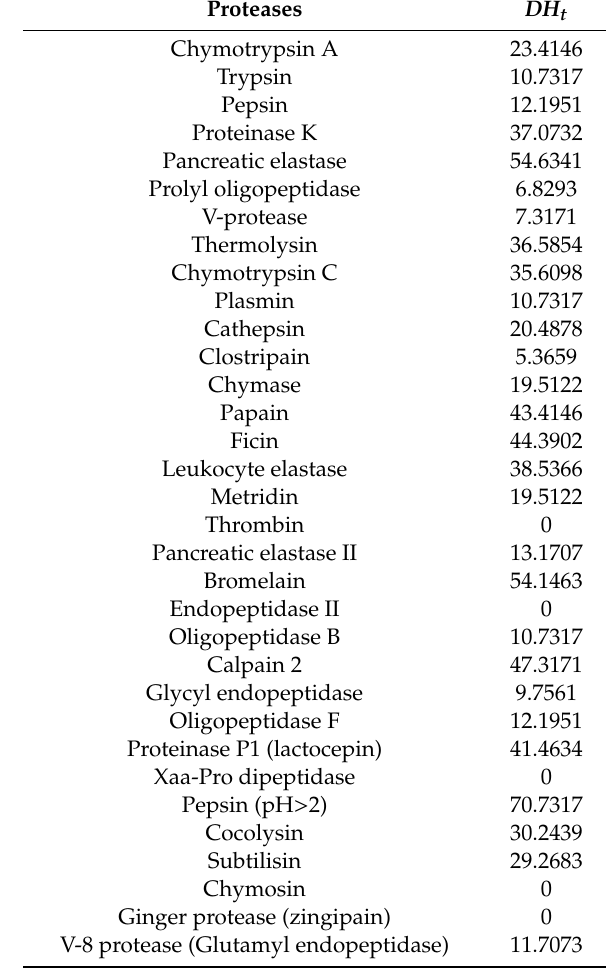
Table 10. Theoretical degree of hydrolysis ( DH t ) values for the following